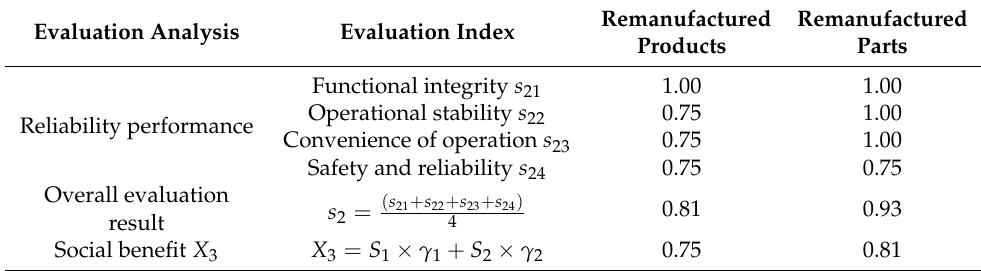
Table 9. P r of remanufactured products or parts.